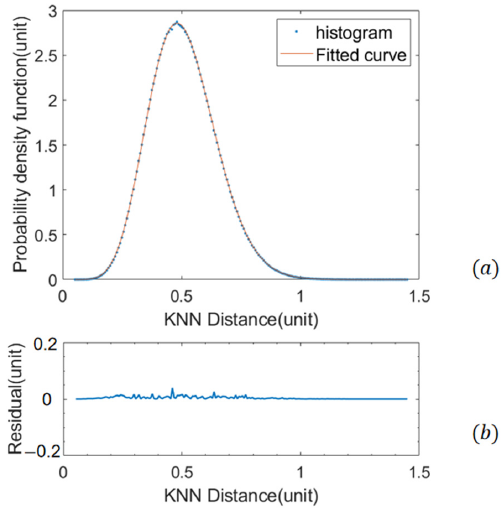
Figure 6. Distribution model of noise (background photon counts rate = 5 MHz). ( a ) The neighboring points of the Euclidean distance histogram distribution of the noise ( b ) Residuals between the fitted results and the true results.